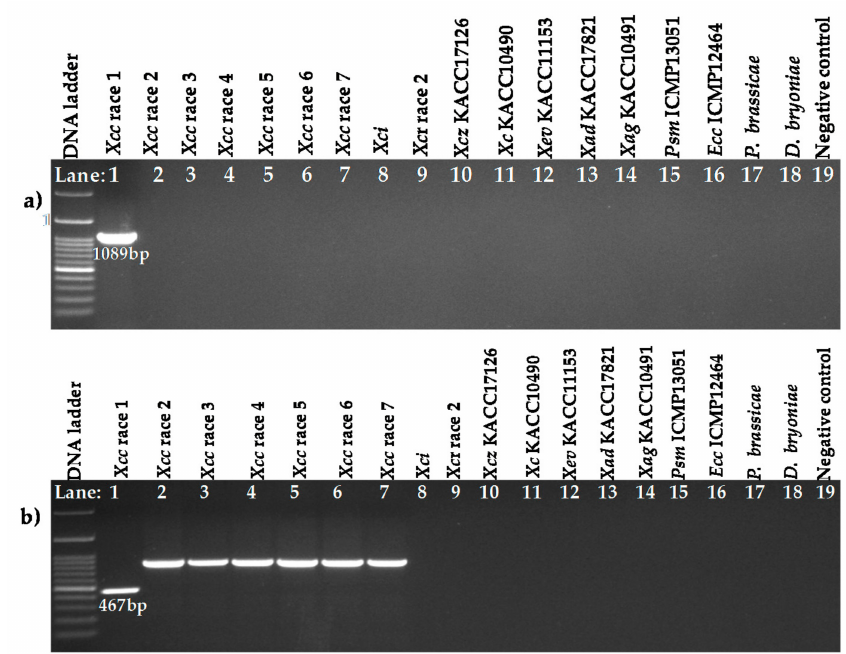
Figure 3. Agarose gel electrophoresis of PCR products from genomic DNA of X. campestris pv. campestris ( Xcc ) races, X. campestris pathovars ( incanae and raphani ) and other bacteria, protist and fungus. Reactions were performed using the primer pairs ( a ) Xcc_47R1_F, Xcc_47R1_R and ( b ) Xcc_85R1_F, Xcc_85R1_R. DNA ladder-100 bp; Lanes 1–7: Xcc race 1 to race 7; Lane 8: Xc i (WHRI-6377); Lane 9: Xcr (WHRI-8305); Lane 10: Xcz (KACC17126); Lane 11: Xc (KACC10490); Lane 12: Xev (KACC11153); Lane 13: Xad (KACC17821); Lane 14: Xag (KACC10491); Lane 15: Pseudomonas syringae pv. maculicola (ICMP13051); Lane 16: Erwinia carotovora subsp. carotovora (ICMP12464); Lane 17: Plasmodiophora brassicae , Lane 18: Didymella bryoniae and Lane 19: Negative control (DDW); gDNA concentration of all samples was 60 ng µ L − 1